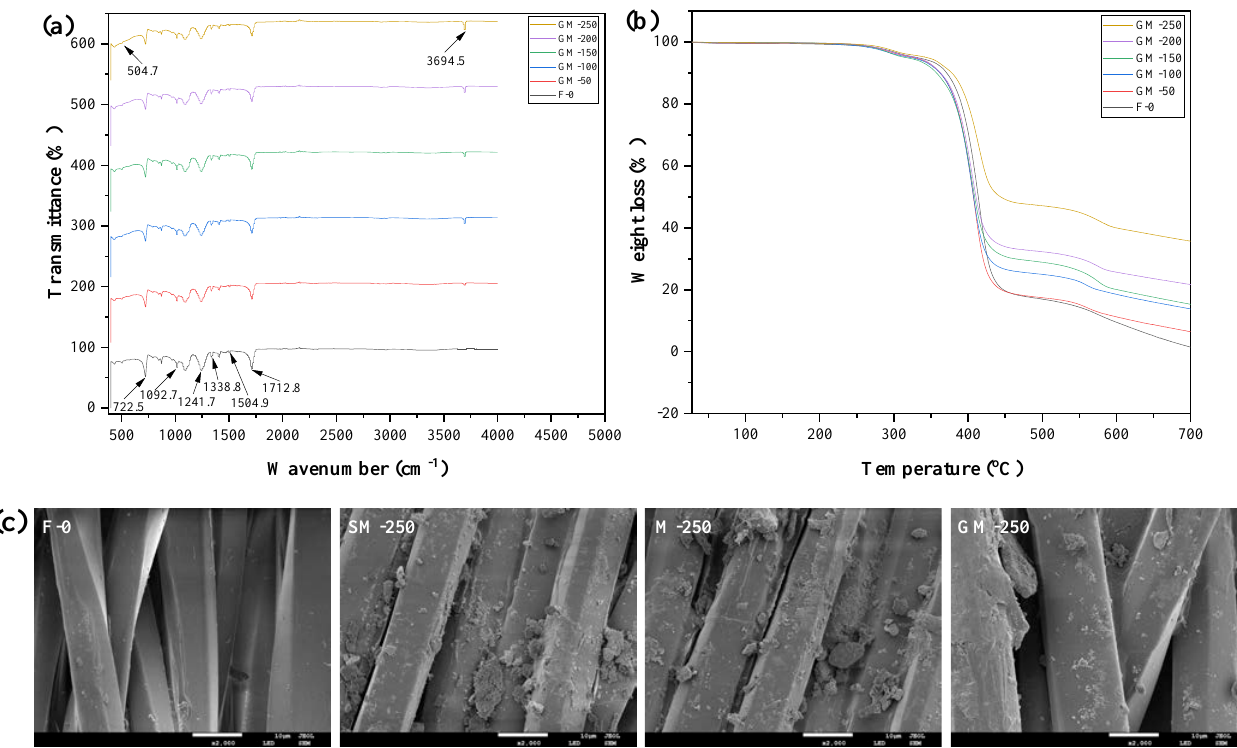
Figure 5. The ( a ) ATR-FTIR spectra, ( b ) TG curves and ( c ) SEM image of the fabrics.